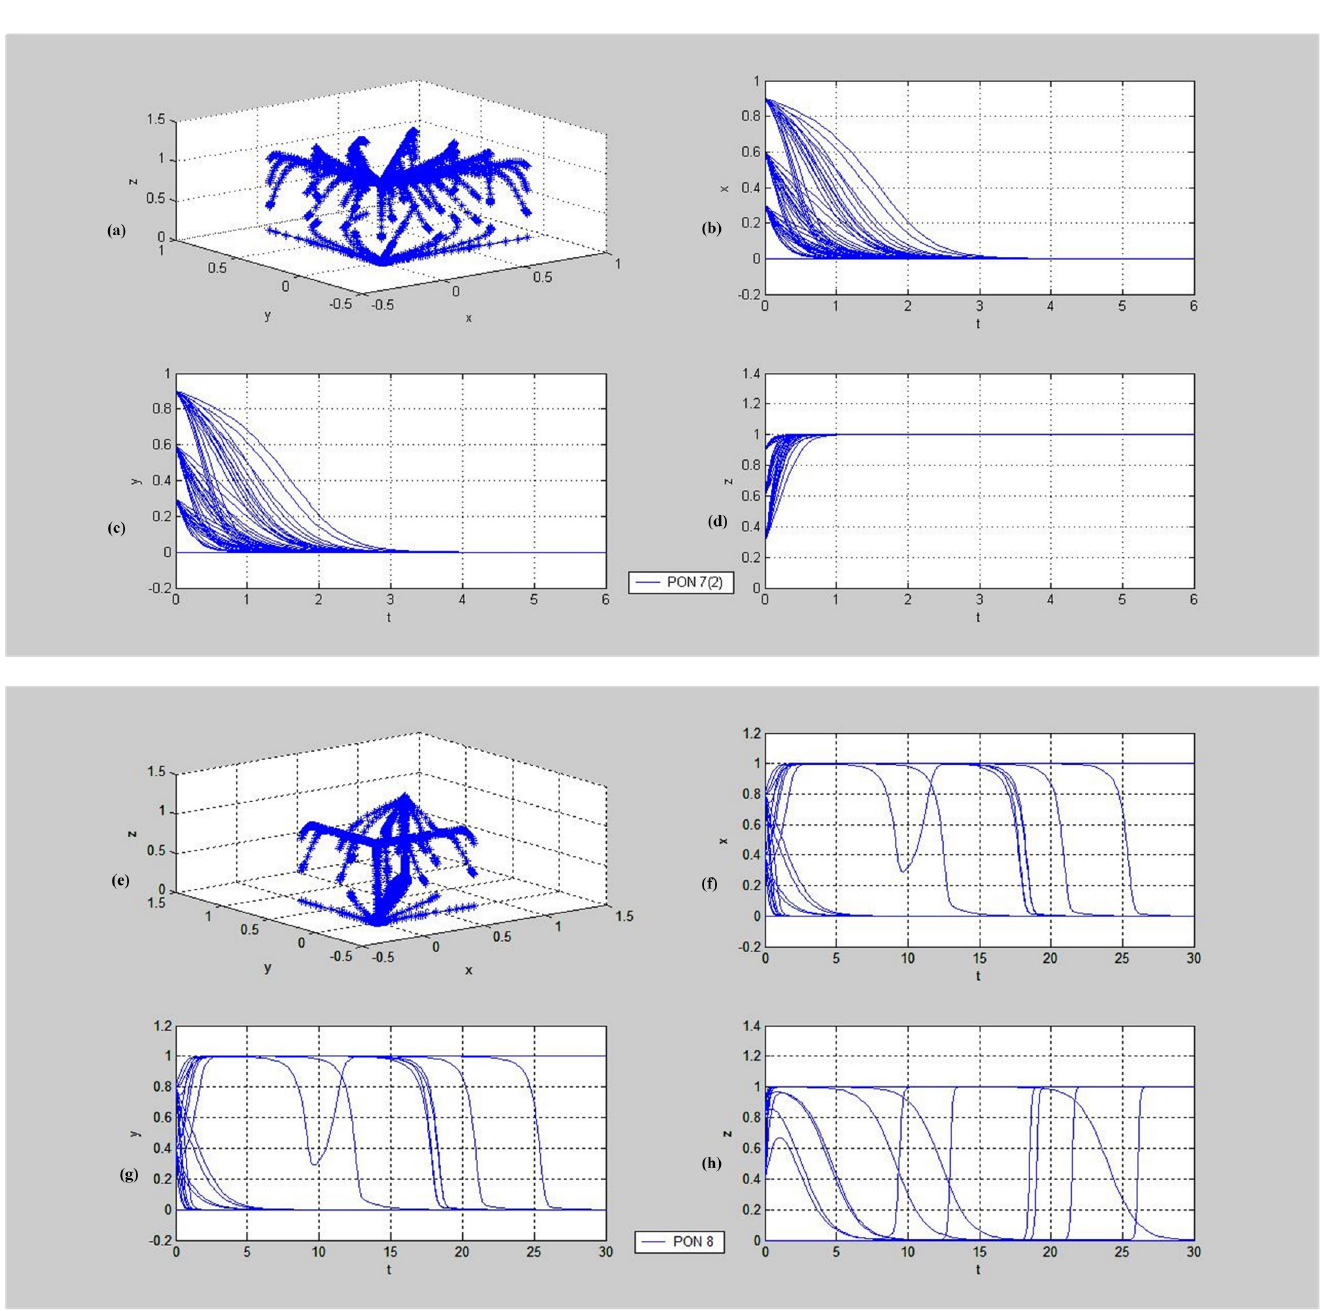
Fig 7. Evolutionary dynamics of strategies stable in (betrayal, betrayal, supervision). PON-Proposition. (a)~(d) demonstrate the phase trajectories of x, y, z and (x, y, z) in the game situations shown in Proposition 7(2): (a) The phase trajectory of (x, y, z) of the entire evolutionary game system over time t; (b) the dynamic evolution characteristic of x, i.e., the proportion of individuals choosing Cooperation strategy in population PPP over time t; (c) the dynamic evolution characteristic of y, i.e., the proportion of individuals choosing Cooperation strategy in population DC over time t; (d) the dynamic evolution characteristic of z, i.e., the proportion of individuals choosing Supervision strategy in population TPIP over time t. (e)~(h) demonstrate the phase trajectories of x, y, z and (x, y, z) in the game situations shown in Proposition 8: (e) The phase trajectory of (x, y, z) of the entire evolutionary game system over time t; (f) the dynamic evolution characteristic of x, i.e., the proportion of individuals choosing Cooperation strategy in population PPP over time t; (g) the dynamic evolution characteristic of y, i.e., the proportion of individuals choosing Cooperation strategy in population DC over time t; (h) the dynamic evolution characteristic of z, i.e., the proportion of individuals choosing Supervision strategy in population TPIP over time